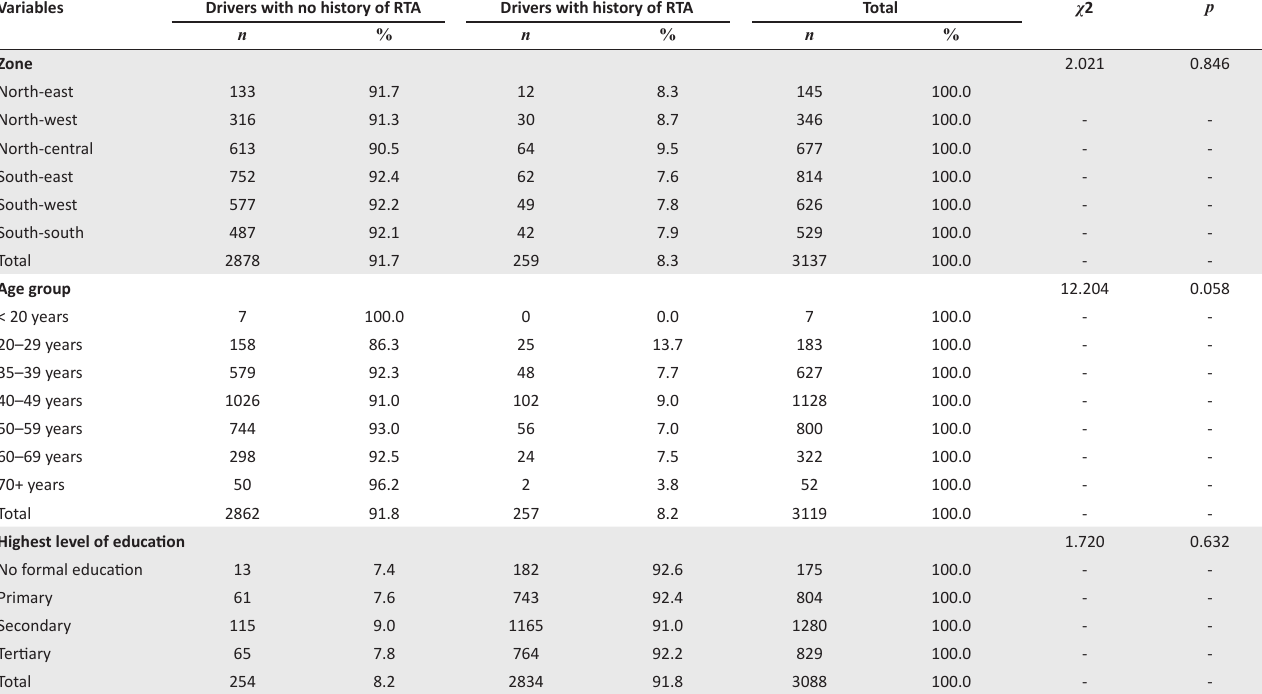
TABLE 3: Reported prevalence of road traffic accidents by zones and age group. Variables Drivers with no history of